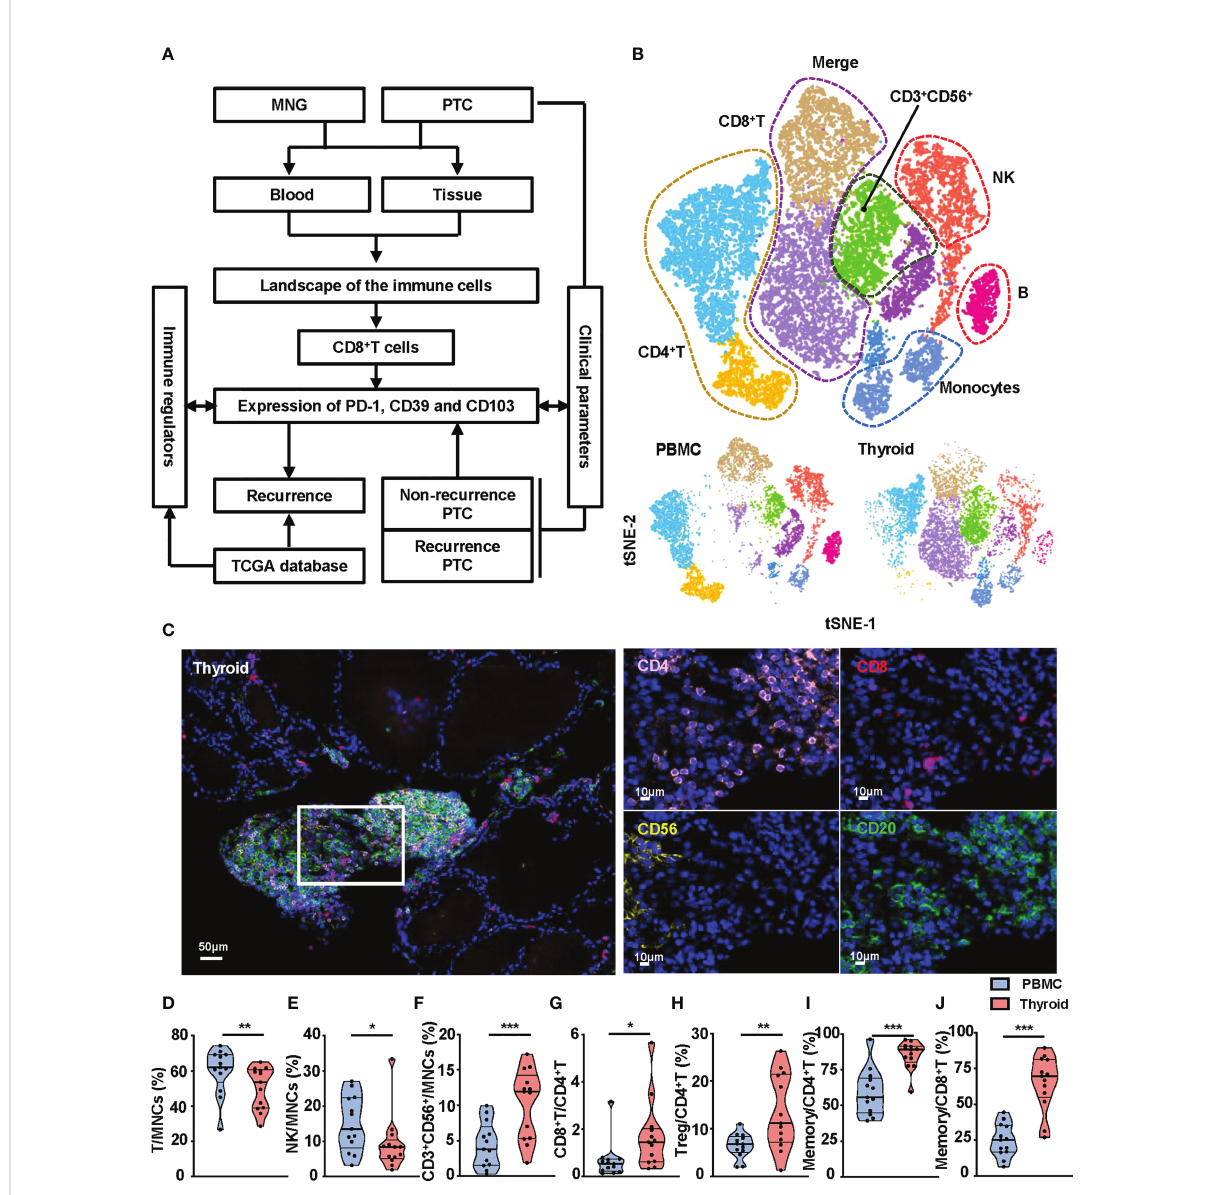
FIGURE 1 Composition of immune cell subsets in peripheral blood and thyroid tissues from MNG patients. (A) The fl owchart of the work. (B) t-SNE islands for CD3 + T cells, CD4 + T cells, CD8 + T cells, CD3 + CD56 + cells, CD56 + NK cells, CD19 + B cells, and CD14 + monocytes of fl ow cytometry data. (C) Representative immuno fl uorescence staining of CD4 (pink), CD8 (red), CD56 (yellow), and CD20 (green) in an MNG. DAPI staining is shown in blue. Scale bar, 50 m m (left), 10 m m (right). Percentages of T cells (D) , NK cells (E) , and CD3 + CD56 + cells (F) in MNCs in peripheral blood and thyroid tissue. (G) Ratio of CD8 + T to CD4 + T cells in peripheral blood and thyroid tissue. (H) Percentage of Treg cells in total CD4 + T cells. Percentages of memory T cells (CD45RO + CD45RA - ) in CD4 + T (I) and CD8 + T (J) cells. (D – J) The individual dot represents a patient, and data are presented as mean ± SEM. *p < 0.05; **p < 0.01; ***p <